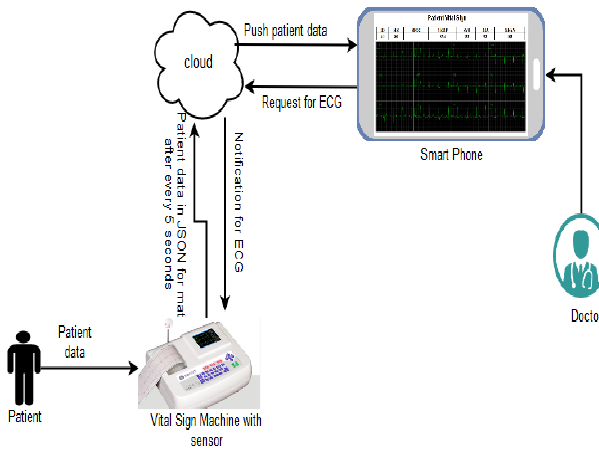
Figure 3. Communication between Doctor and User Interface